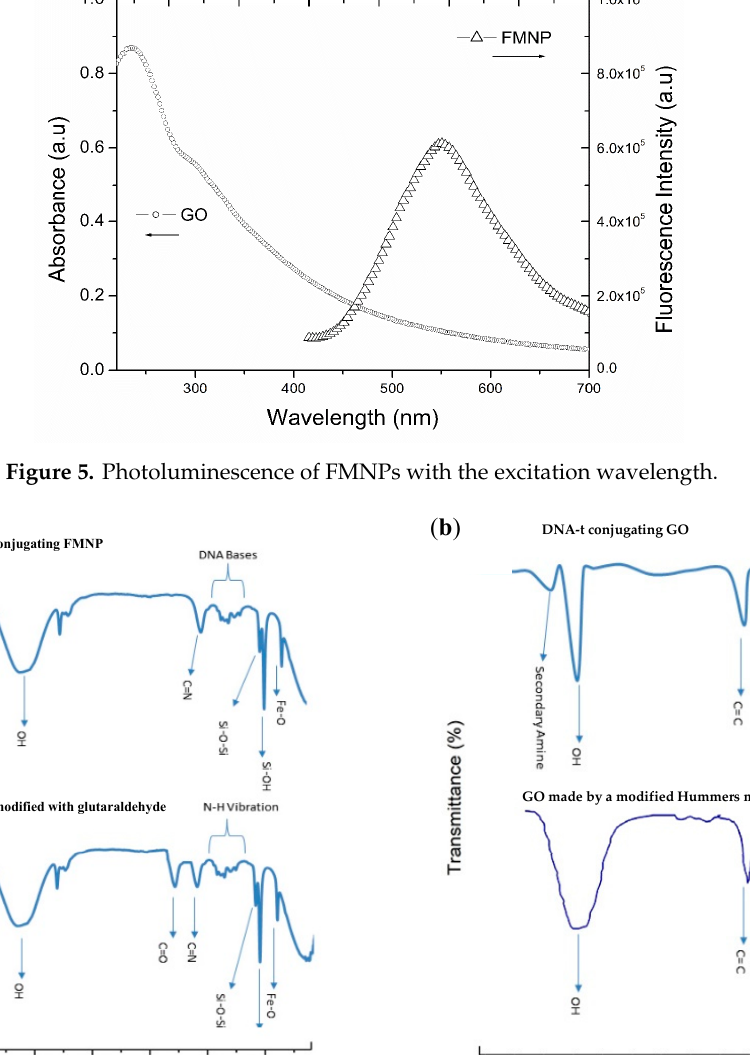
Figure 5. Photoluminescence of FMNPs with the excitation wavelength.